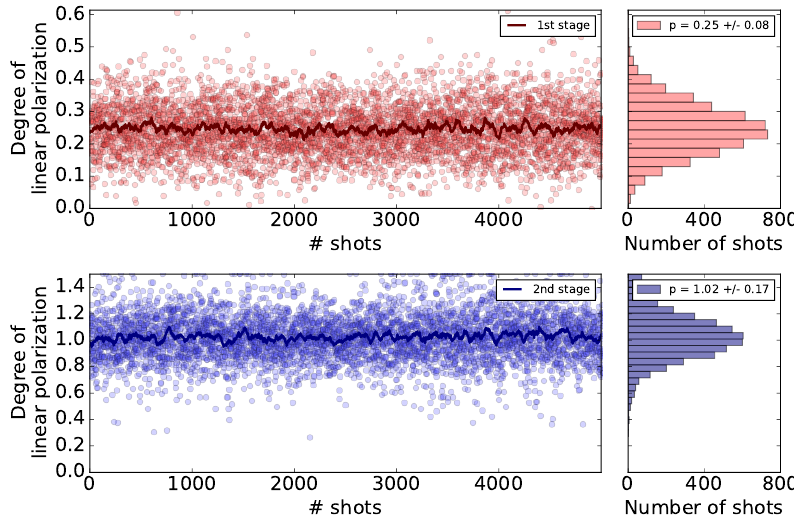
Figure 5. Degree of linear polarization P lin of the first stage ( red ) and of the second stage ( blue ). The undulators of the first stage were tuned in circular right polarization at 26.1 nm and the second stage was tuned in linear horizontal polarization at 5.22 nm. The deduced degree of circular polarization is P circ = 0.96. The lines represent the moving average over 50